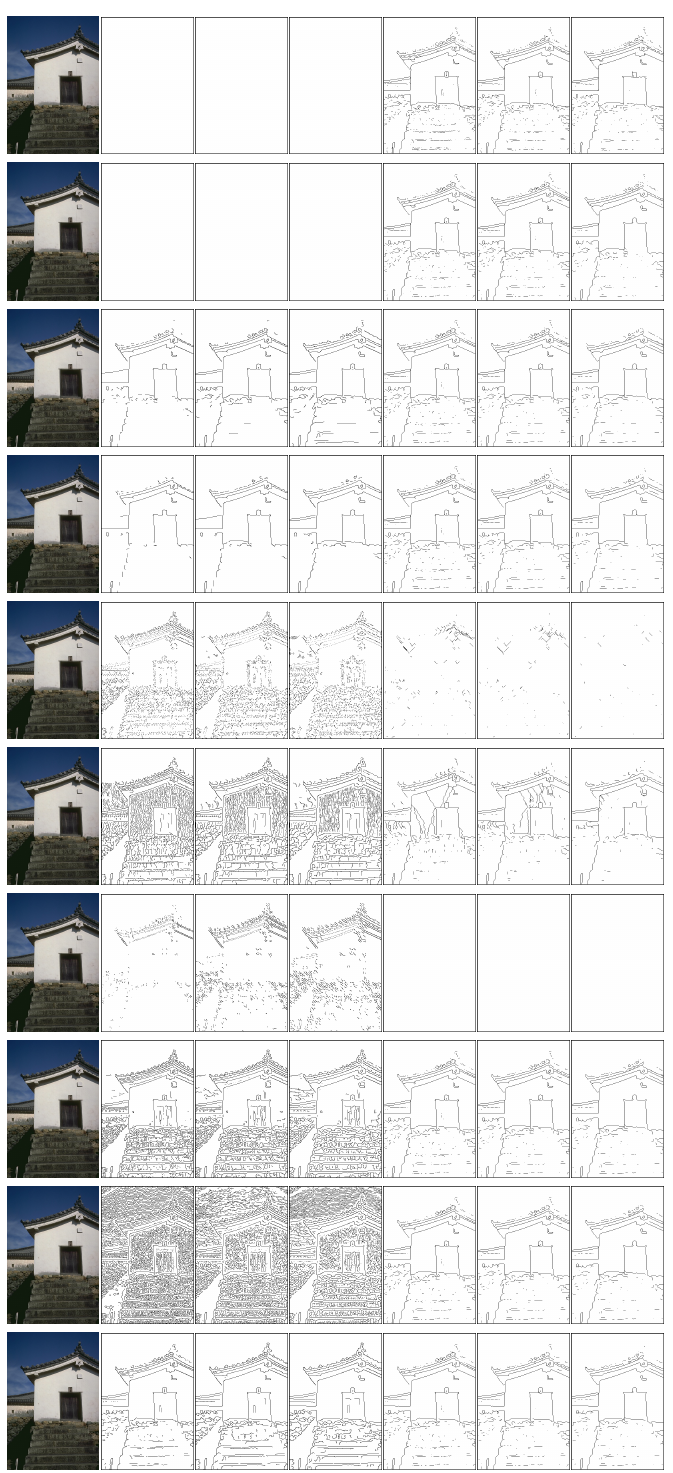
Figure A12. Canny and ED results. Columns: Original, Canny 3 × 3, Canny Dilated 5 × 5, Canny Dilated 7 × 7, ED 3 × 3, ED Dilated 5 × 5 and ED Dilated 7 × 7. Rows: Pixel Differences, Separated Pixel Difference, Sobel, Prewitt, Kirsch, Kitchen, Kayyali, Scharr, Kroon and